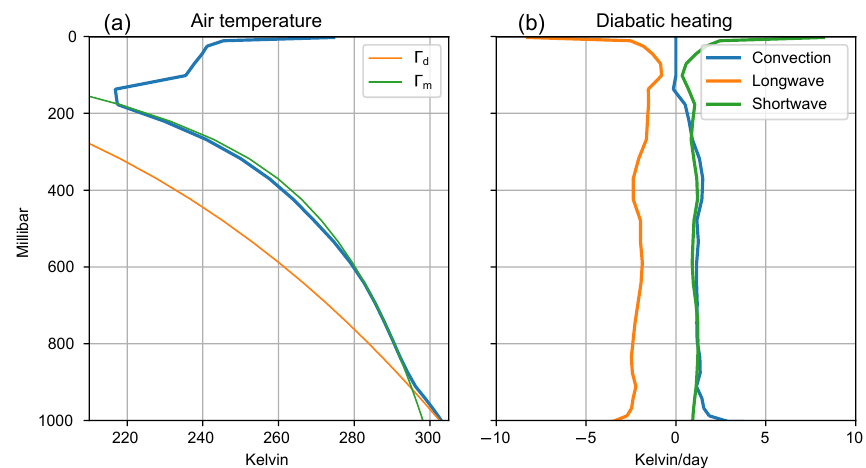
Figure 8. The mean equilibrium profiles in the radiative–convective single-column model. The mean temperature is presented in (a) , along with the dry and moist adiabats which are orange and green respectively. The mean heating profiles are presented in (b) , which shows a stratosphere in radiative equilibrium and a troposphere in radiative–convective equilibrium.